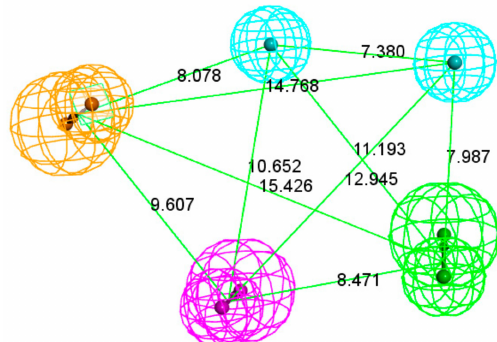
Figure 1. Pharmacophore model Hypo 1A. As the figure shows, the aromatic ring point is orange, the hydrophobic point is blue, the hydrogen bond acceptor is green, and the hydrogen bond donor is purple. The distance between the pharmacophore features is reported in